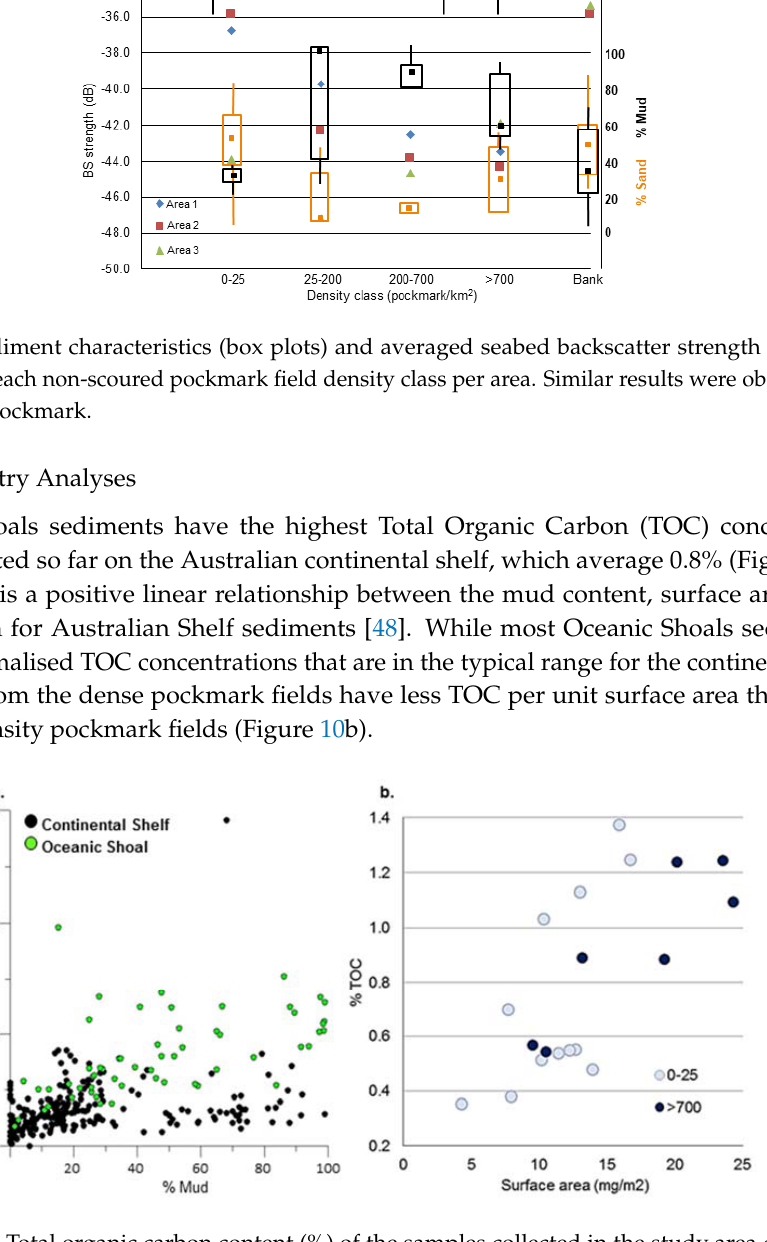
Figure 8. Ternary diagram illustrating the relative proportions of Sand, Silt, and Clay (after [47]) indicating the dominance of silt over clays in the muddy sediments of the Oceanic Shoals.